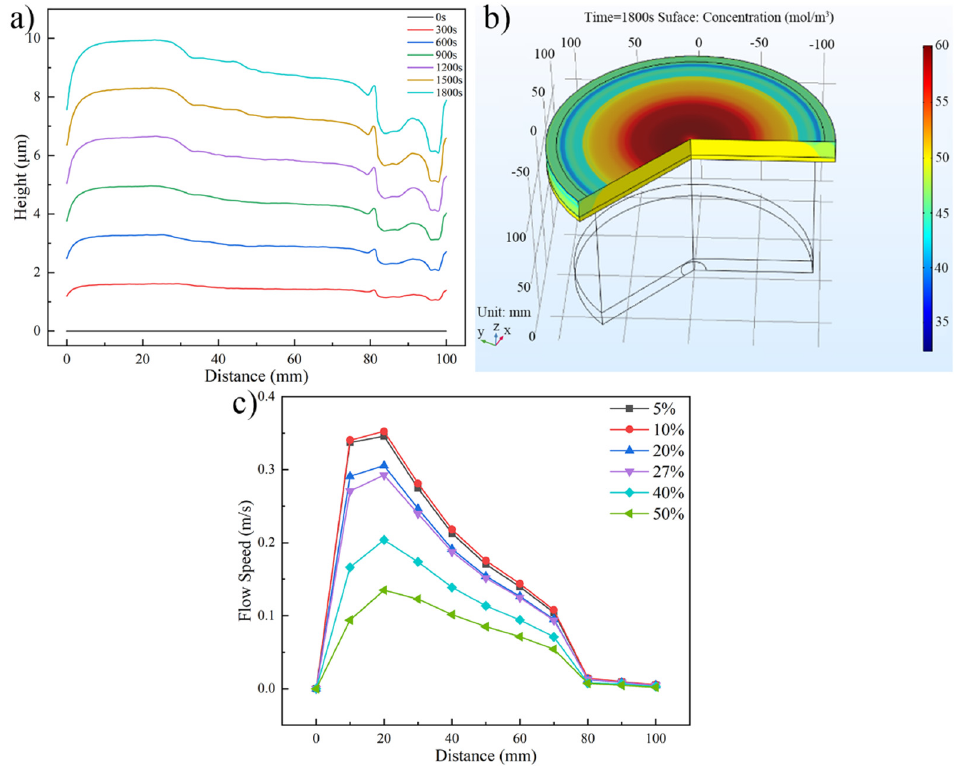
Figure 10. Distributions of the Au bump height, Au+ concentration, and flow speed. ( a ) Au bump height distribution along the wafer radius (Ti wire mesh density is 5%), ( b ) Au+ concentration distribution on the wafer surface (Ti wire mesh density is 5%), and ( c ) flow speed distribution on the wafer surface at different Ti wire mesh densities.